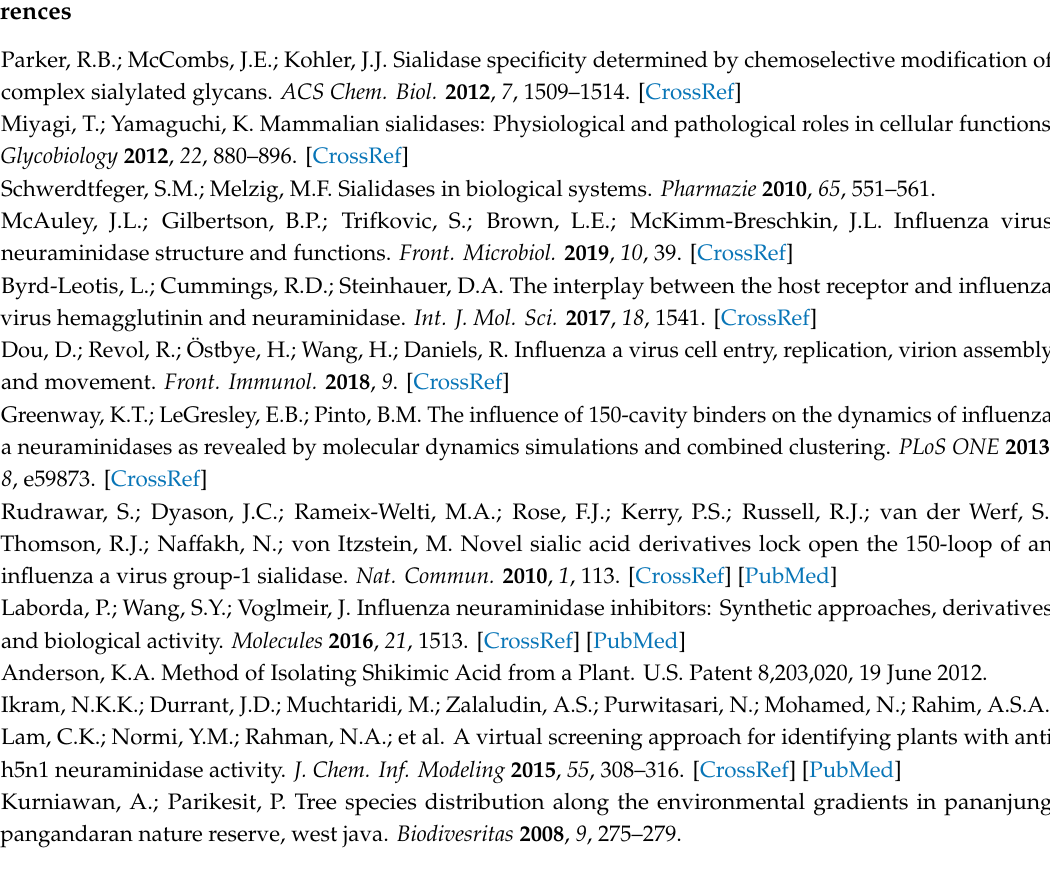
Supplementary Materials: The following are available online, Figure S1: Spectral Data, Figure S2: Isolation Methods, Melting points and Spectral data of